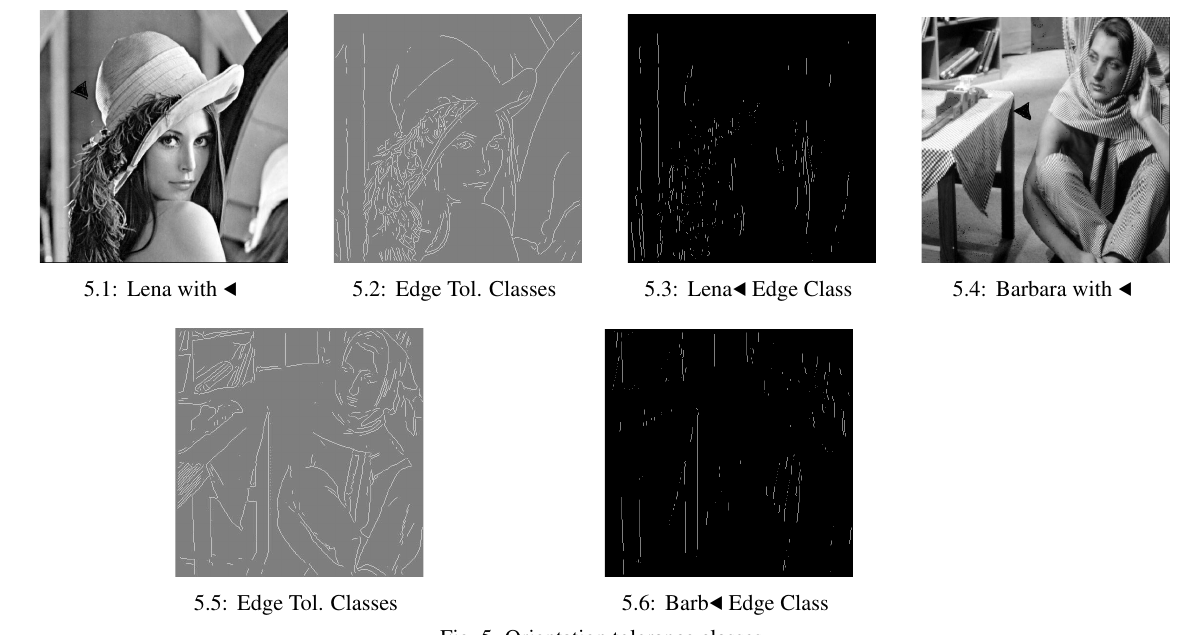
Fig. 5. Orientation tolerance